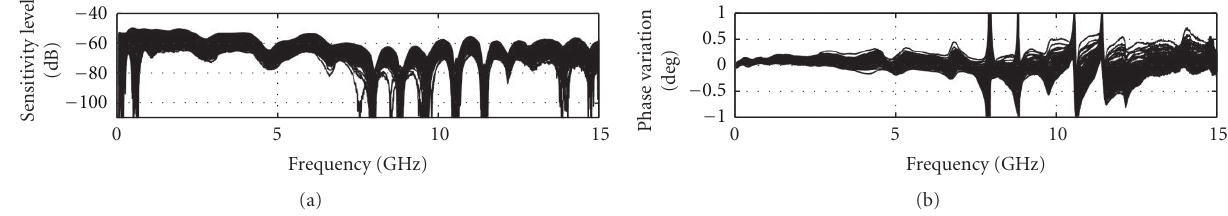
Figure 8: Sensitivity calculated based on a pair full TSAR scan (200 positions) with the antenna attached and immersion medium present (as per a volunteer scan).